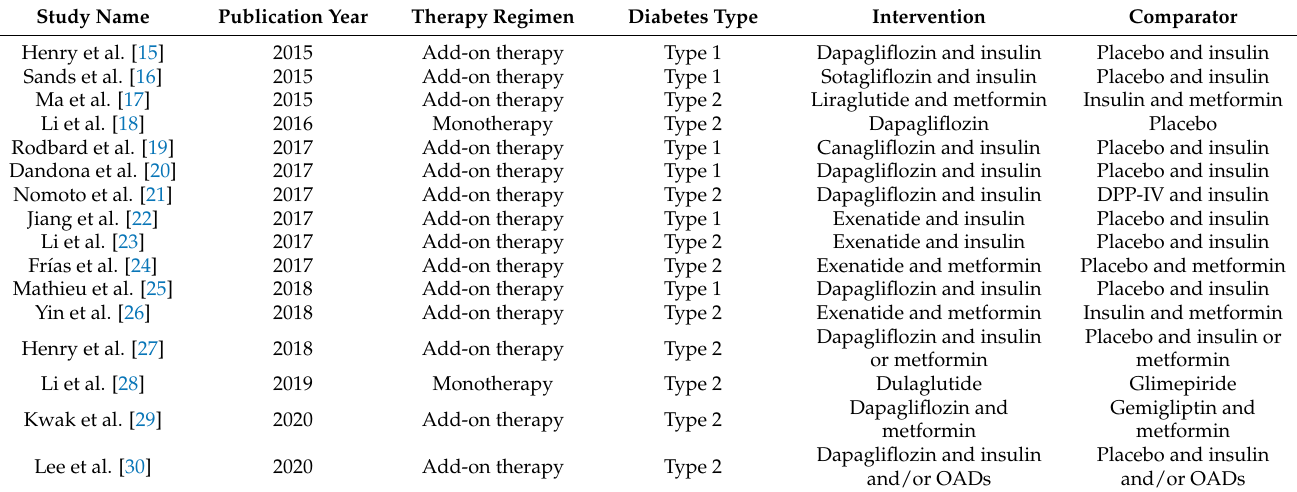
Figure 1. The flowchart of the study selection process for the meta-analysis. GLP-1: glucagon-like peptide 1; SGLT-2: sodium-glucose cotransporter-2.